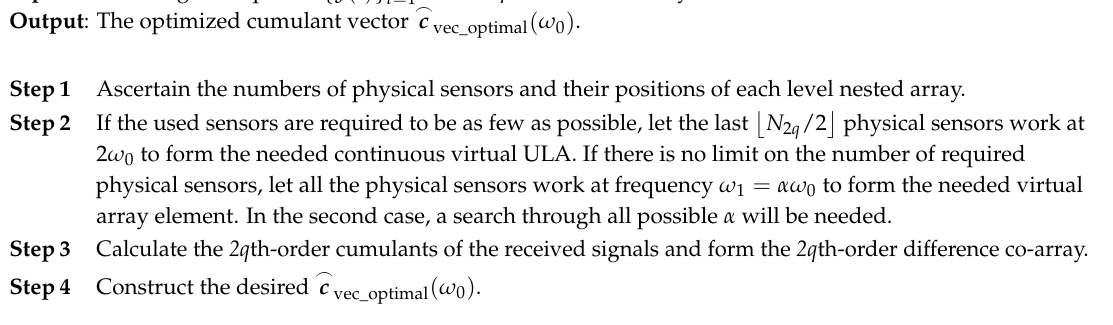
Algorithm 2. Summary of the Multi-Frequency Method for a Minimum Number of Frequencies